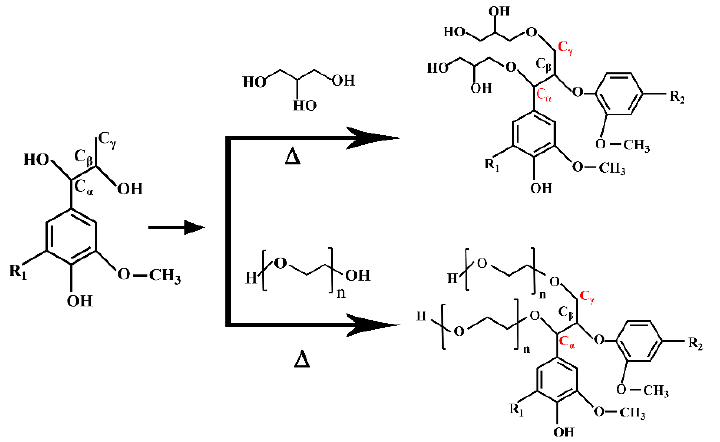
Figure 3. Reaction of lignin degradation products with liquefied solvents to form polyols.